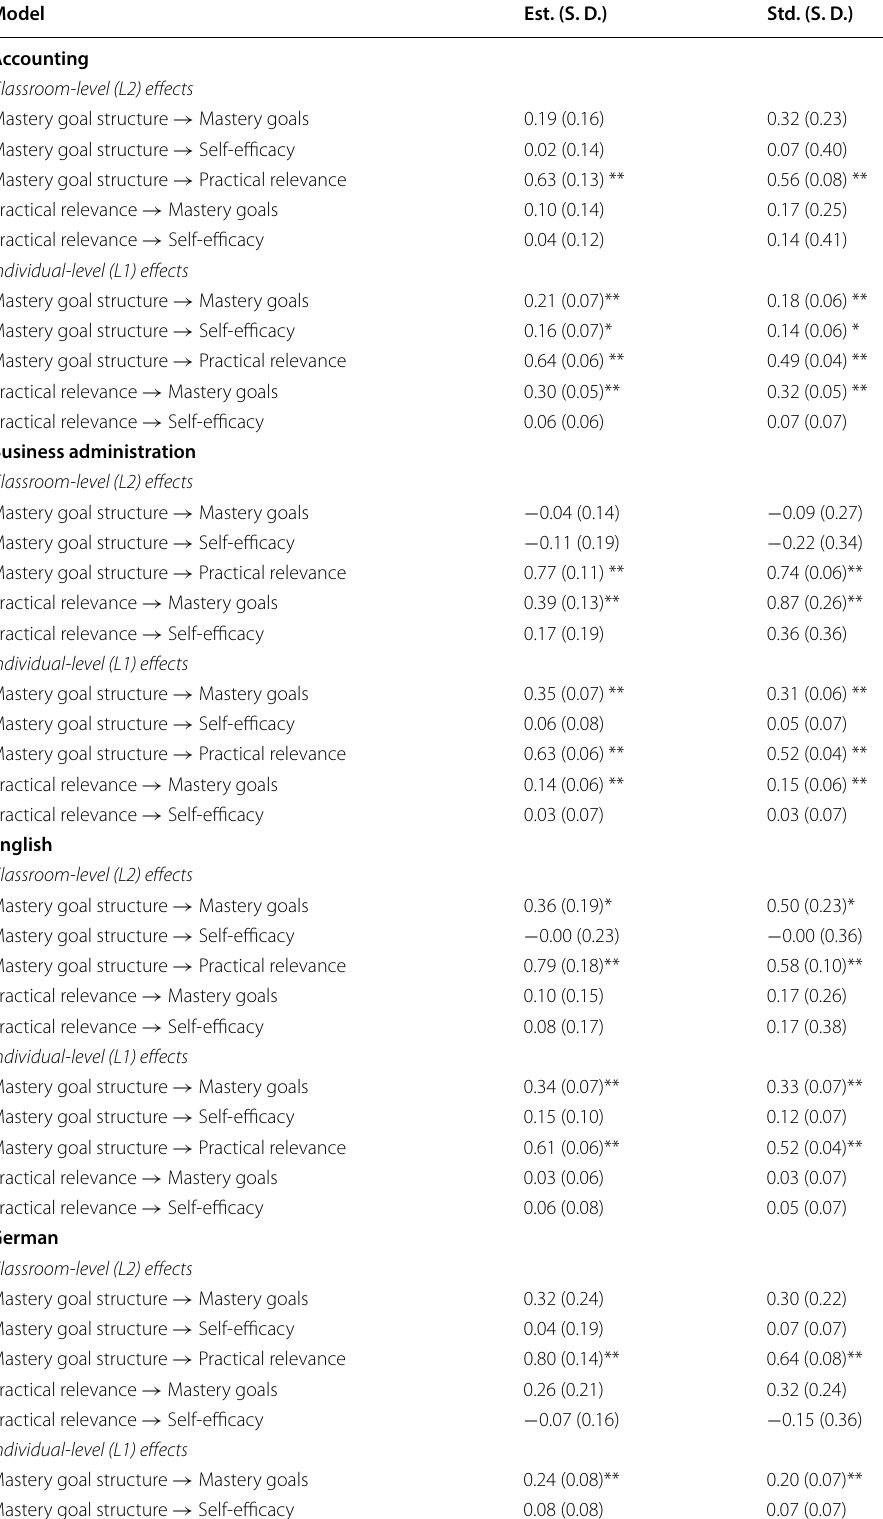
Table 2 Main effects from the multilevel predictive models Model Est. (S. D.) Std. (S.